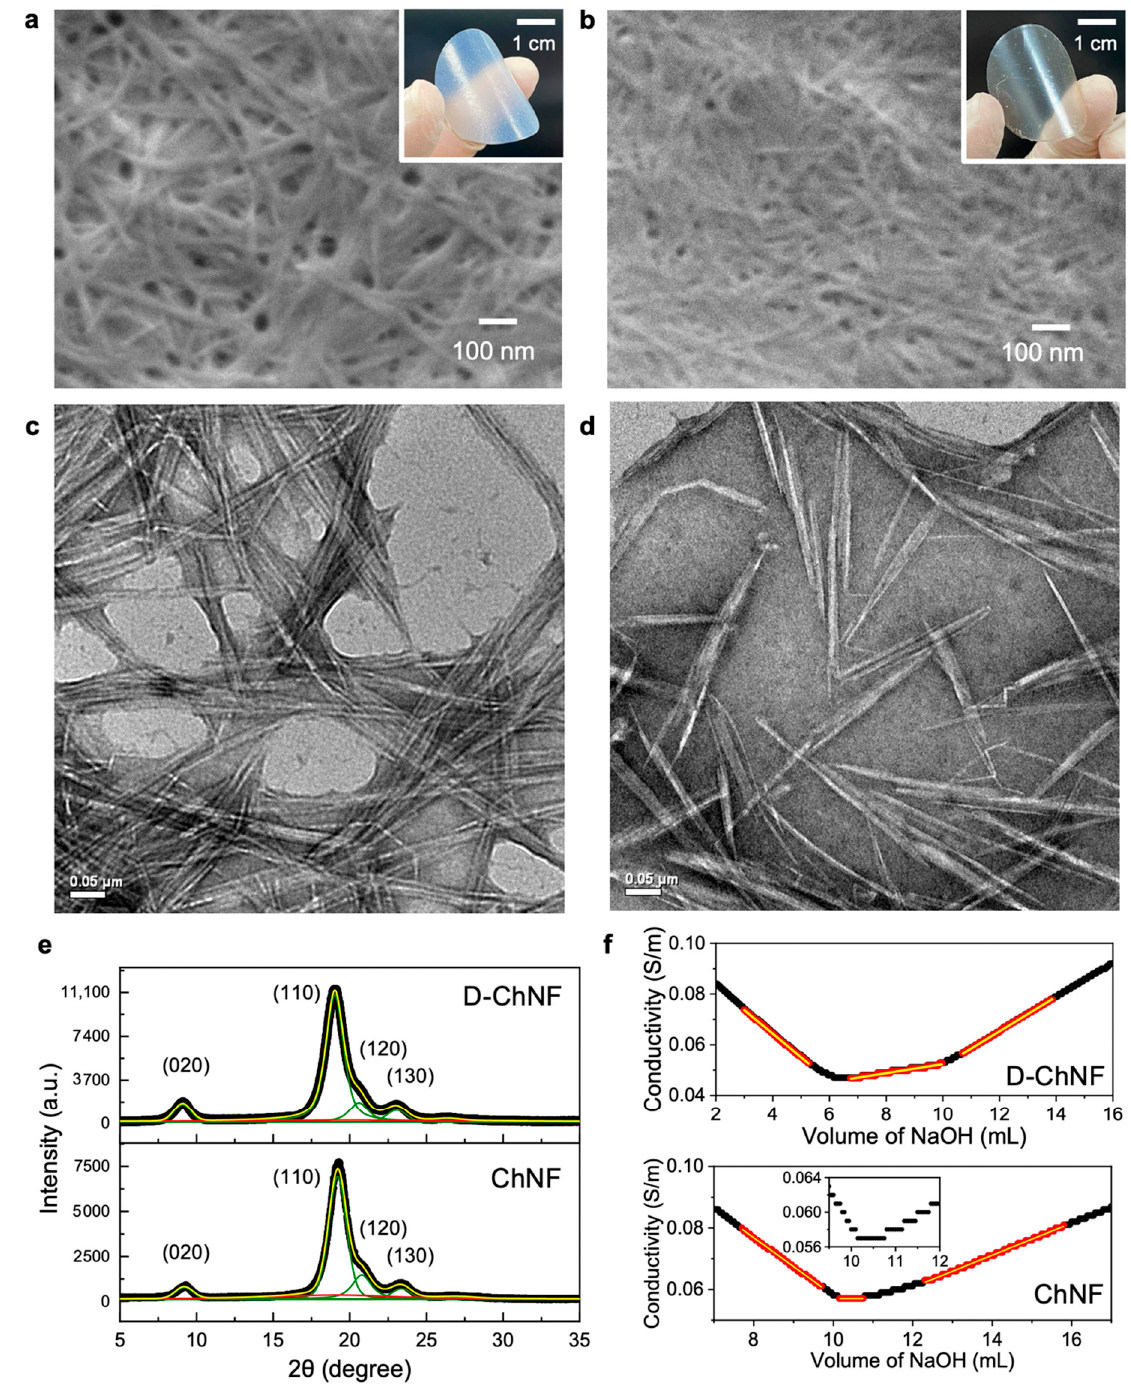
Figure 1. Characterization of D-ChNF and ChNF. FESEM images of ( a ) ChNF and ( b ) D-ChNF. The inserts show the appearance of the films. TEM images of ( c ) ChNF and ( d ) D-ChNF. ( e ) Typical X-ray diffraction profiles of D-ChNF and ChNF. The profiles were deconvoluted into the green and red peaks originating from crystalline and amorphous diffraction, respectively, and fitted by the cumulative fit (yellow profile). ( f ) Conductometric titration plots of D-ChNF and ChNF. The red plots were fitted with the yellow lines, and consumption of 0.05 M NaOH solution was calculated from the two intersections of the three fitted lines. The inset for ChNF shows the magnified plot at around the plateau